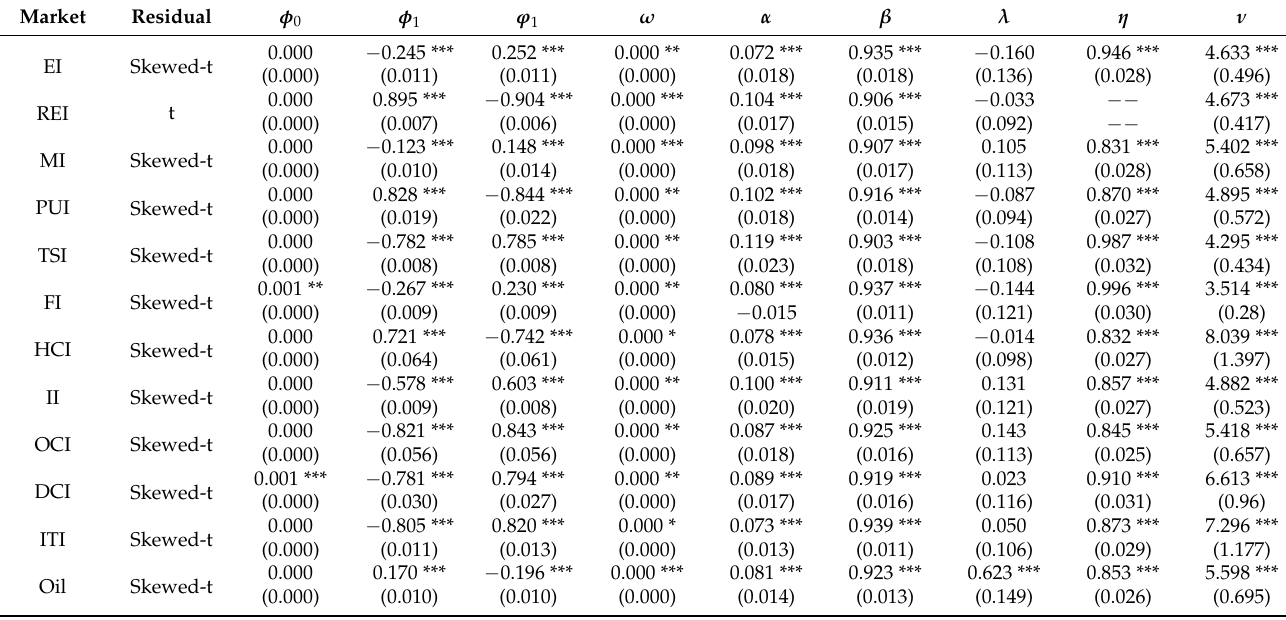
Table 3. Estimates of marginal distribution models (after the